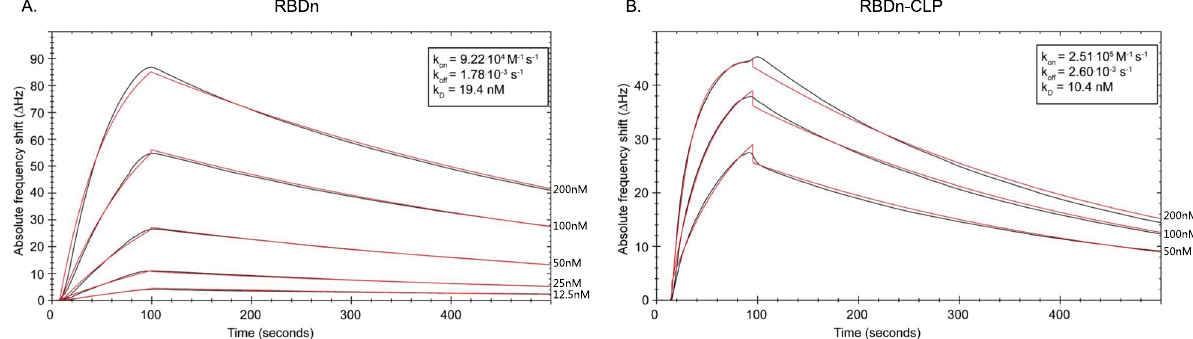
Fig. 3 ACE2 binding kinetics for RBDn and RBDn-CLP. a Binding of RBDn to immobilized hACE2. b Binding of ExpreS 2 produced ACE2 to immobilized RBDn-CLP. Real time binding (black curves) are fi tted using a 1:1 simple binding model (red curve). Analyte concentrations are shown to the right and k on , k off , and k D are